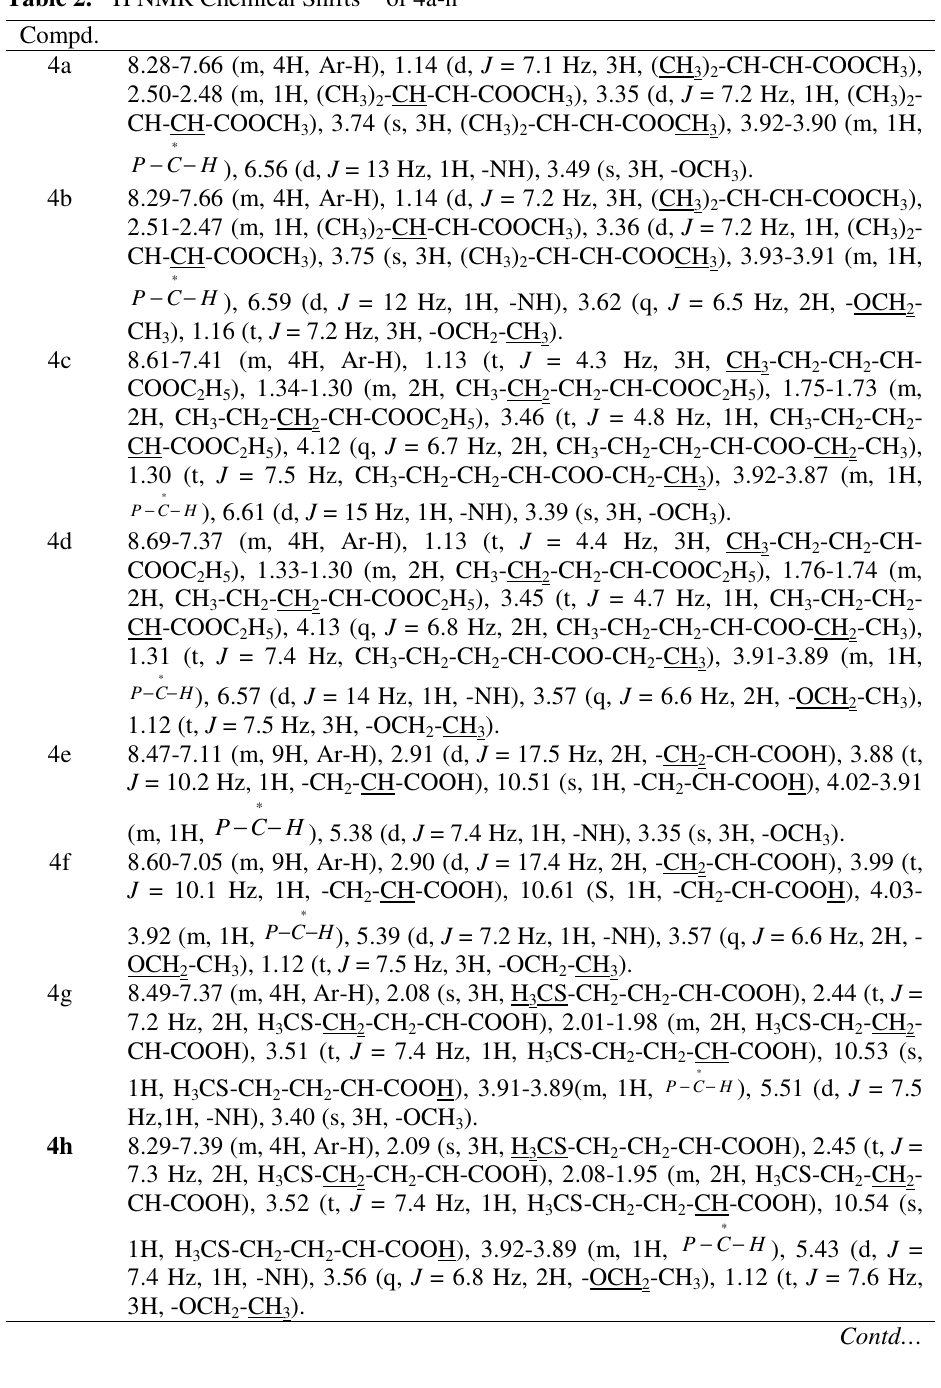
Table 2. 1 H NMR Chemical Shifts a,b of 4a-n